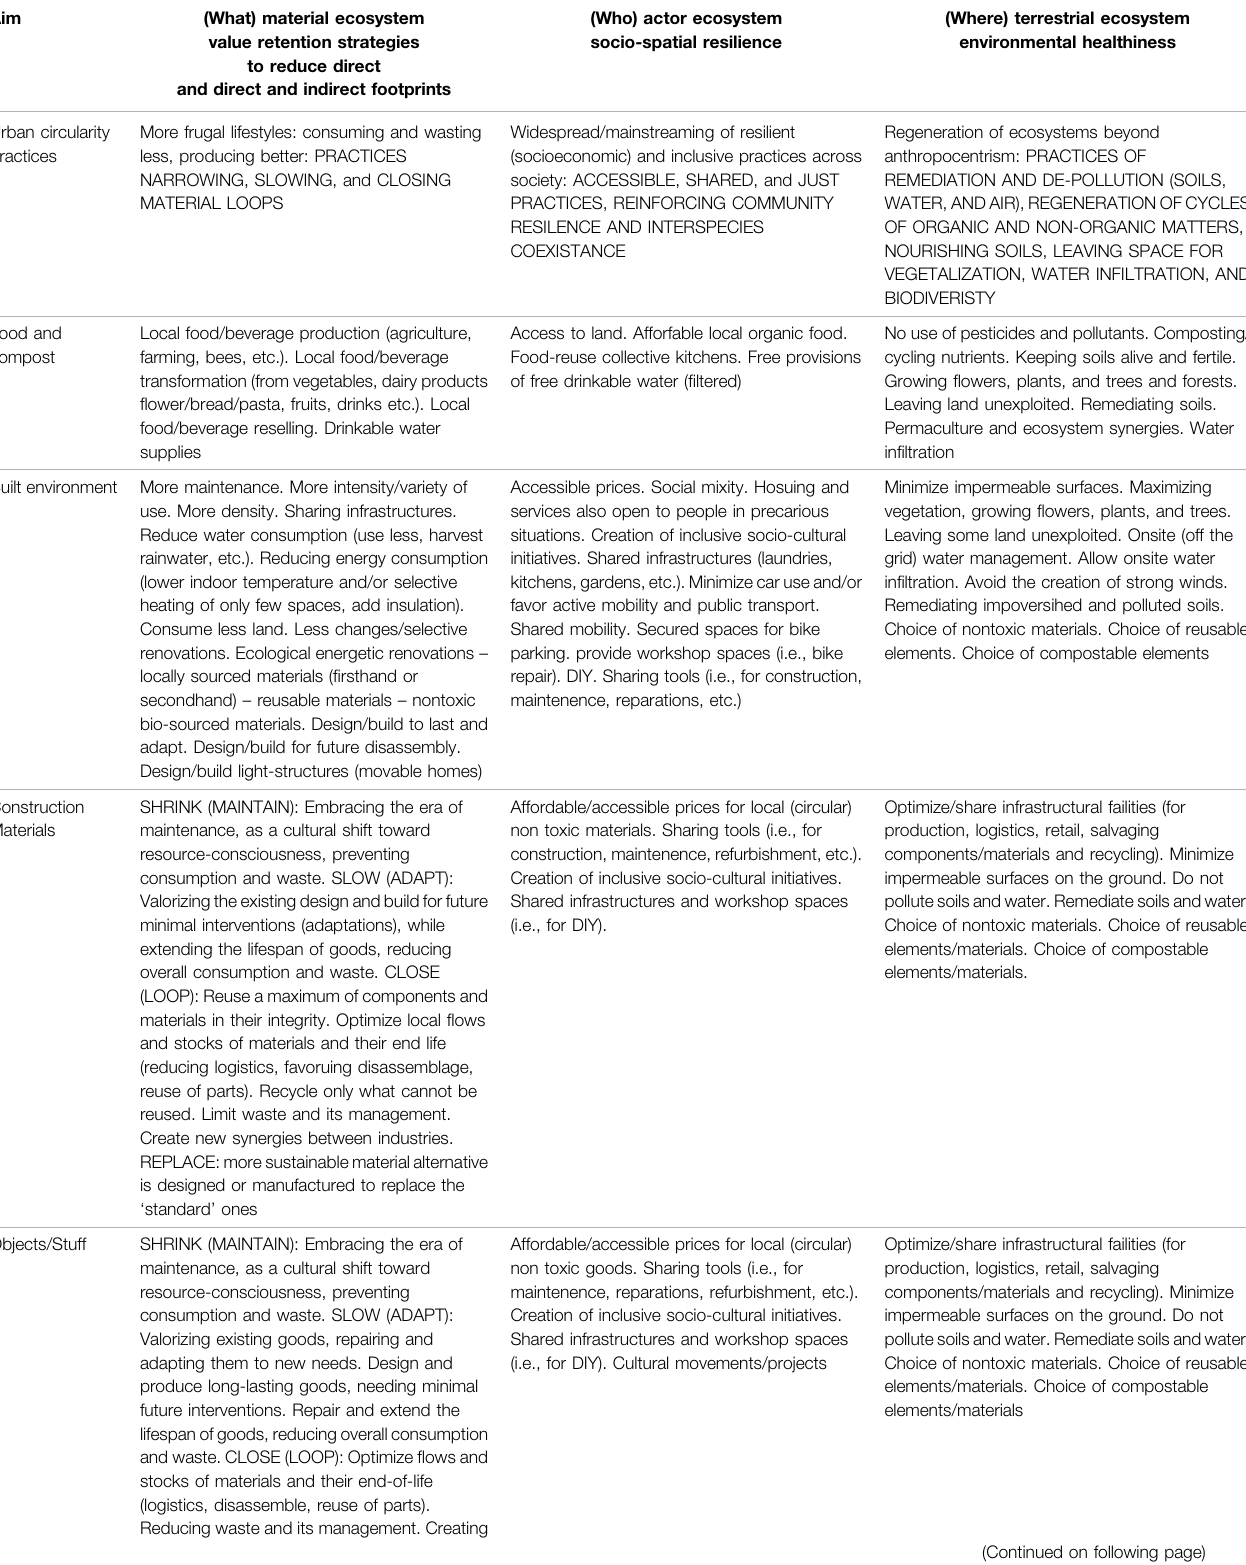
TABLE 1 | UCPs across four metabolic questions and categorized according to our de fi nition of UC in three tracks: 1) value retention – oriented, 2) socio-spatial resilience – oriented, and 3) environment-oriented, by the authors. Aim (What) material ecosystem (Who) actor ecosystem (Where) terrestrial ecosystem value retention strategies socio-spatial resilience environmental to reduce direct and direct and indirect footprints